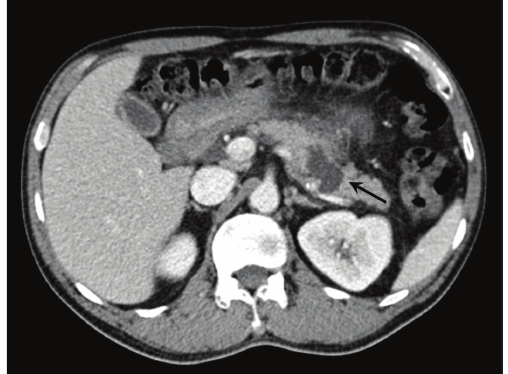
Figure 1: 4.1 cm pancreatic pseudocyst in distal pancreatic body (marked by